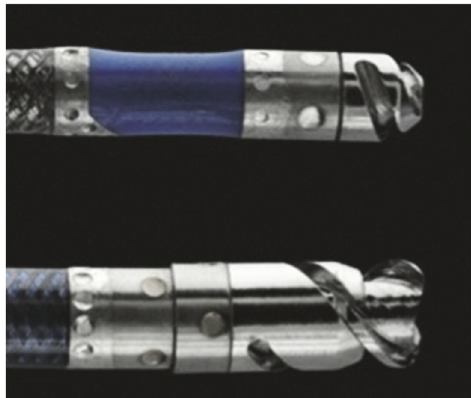
Figure 7: Wildcat catheter tip with a double wedge tip [permission to reproduce the image obtained from Elsevier through Rightslink license 3877131507083 dated 27 May